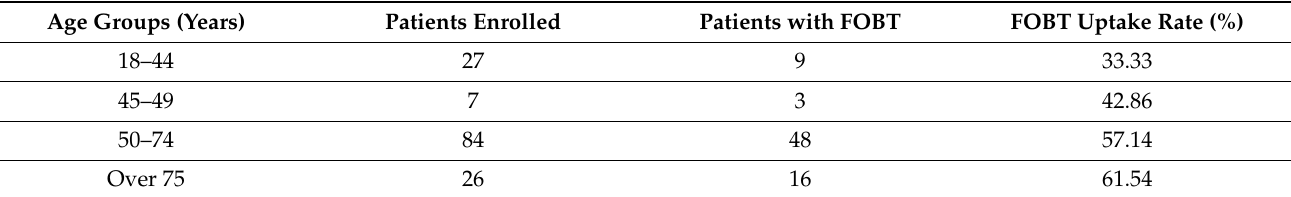
Table 1. FOBT uptake rate by age group.